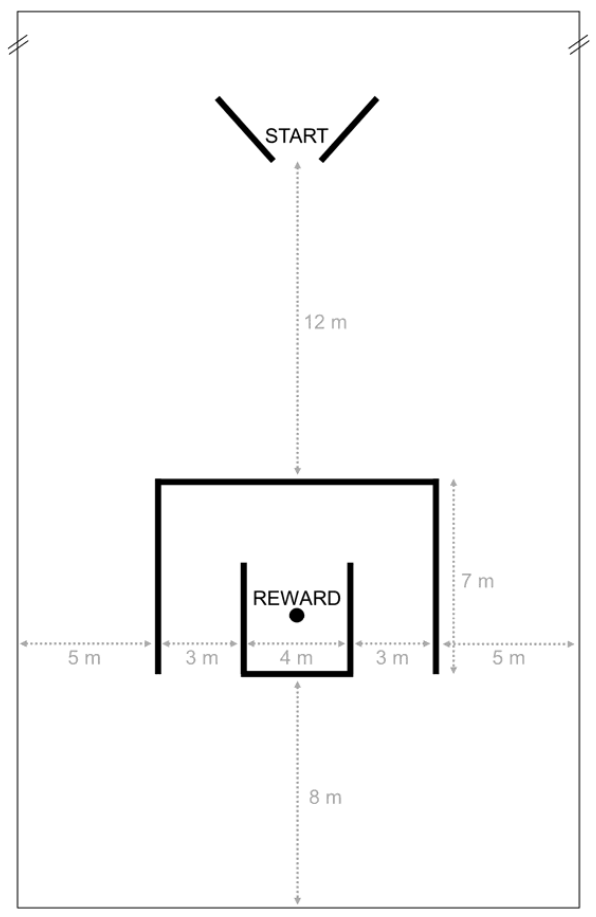
Figure 1. Overview of the experimental setup in the test arena.